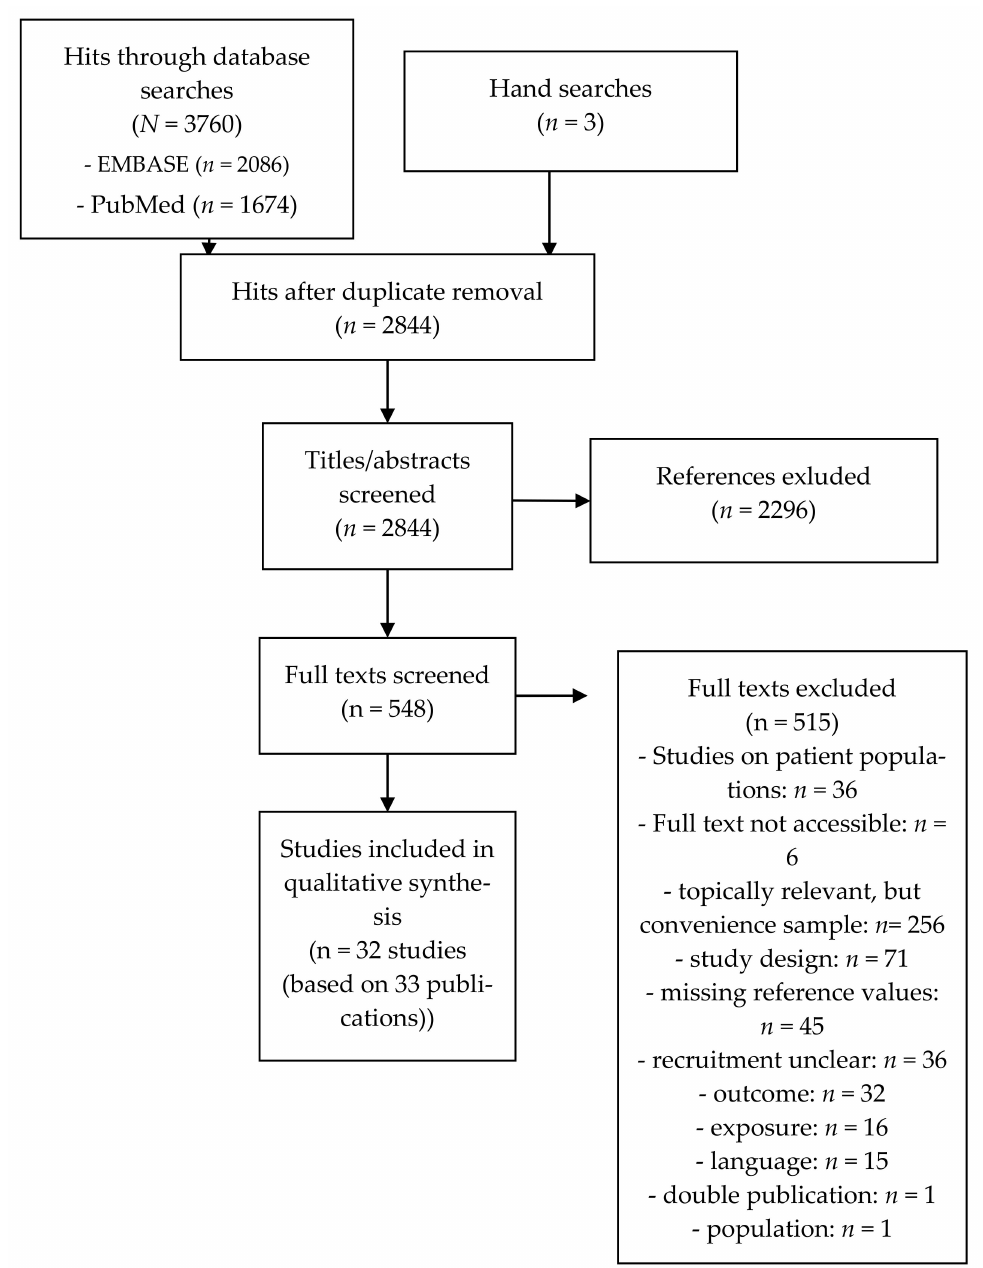
Figure 1. PRISMA-Flow Chart (search date: 17 March